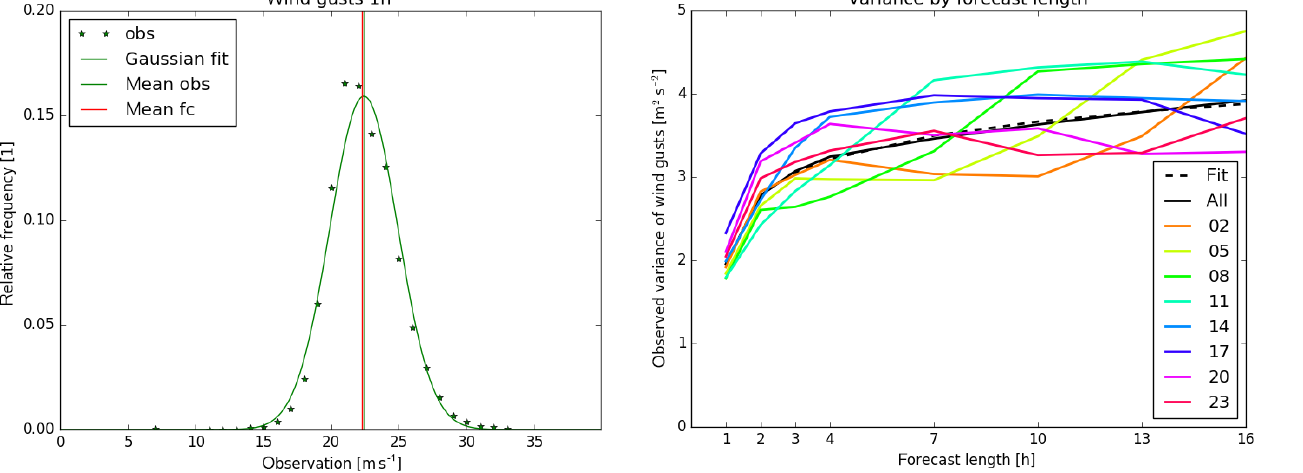
Figure 5. Variances σ 2 t of logistic distributions fitted to cumulative distributions of observed wind gusts for threshold t = 13 . 9ms − 1 depending on forecast lead time. Individual runs of Ensemble-MOS for COSMO-DE-EPS-MOS starting at 02:00, 05:00, ... , 23:00UTC in colours, mean of all runs in black, fitted parameterisation of vari- ances dashed in